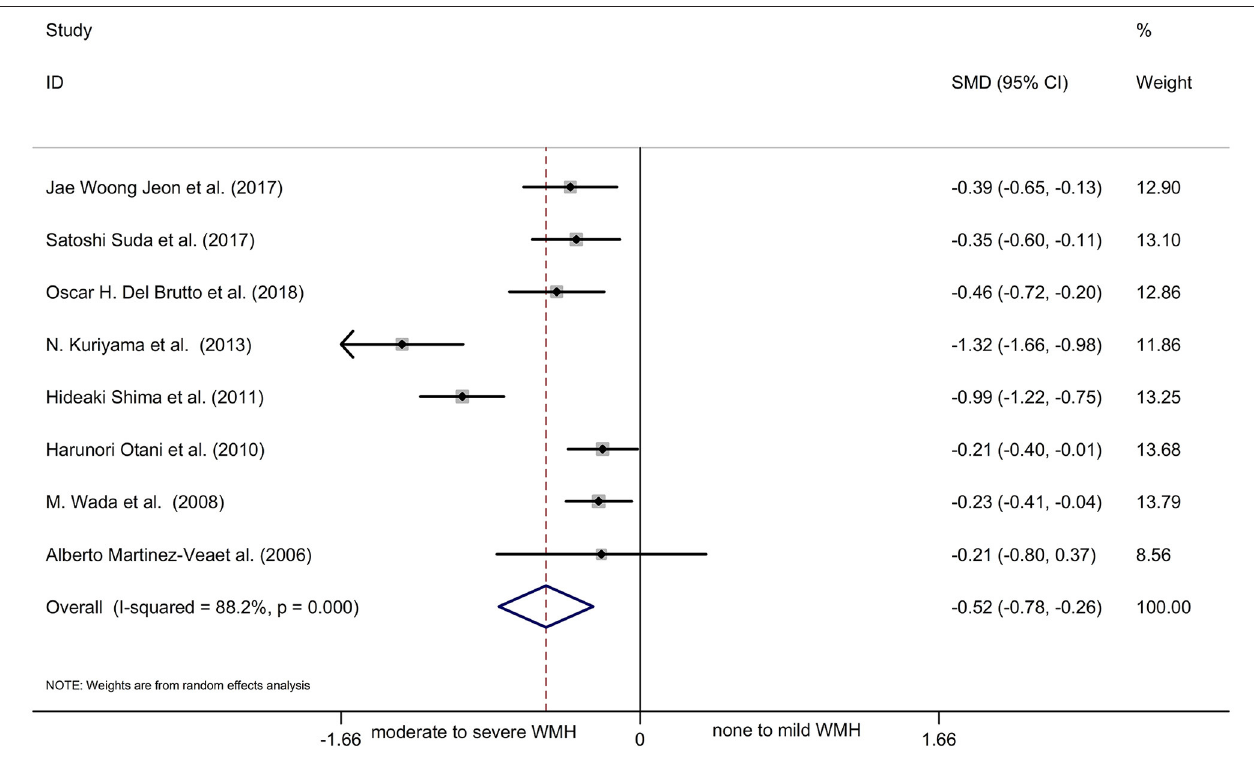
FIGURE 3 | A forest plot of comparison of none-to-mild WMH vs. moderate-to-severe WMH.